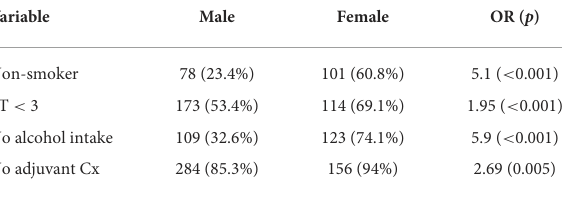
TABLE 4 Crosstab and chi square test for sex and other nominal parameters that are associated with